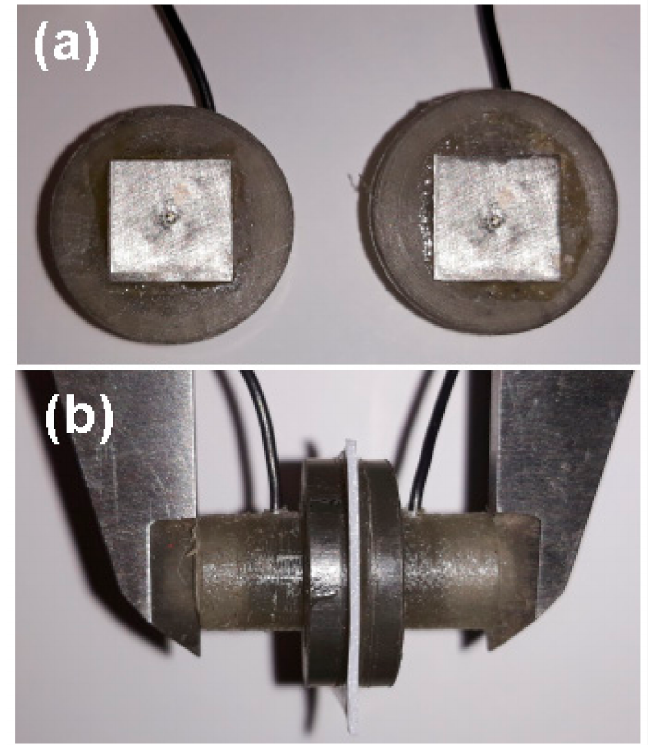
Figure 3. Electrochemical cell for EIS measurements: ( a ) two symmetrical platinum electrodes and ( b ) small sample of wet prepared polymeric membrane placed between platinum